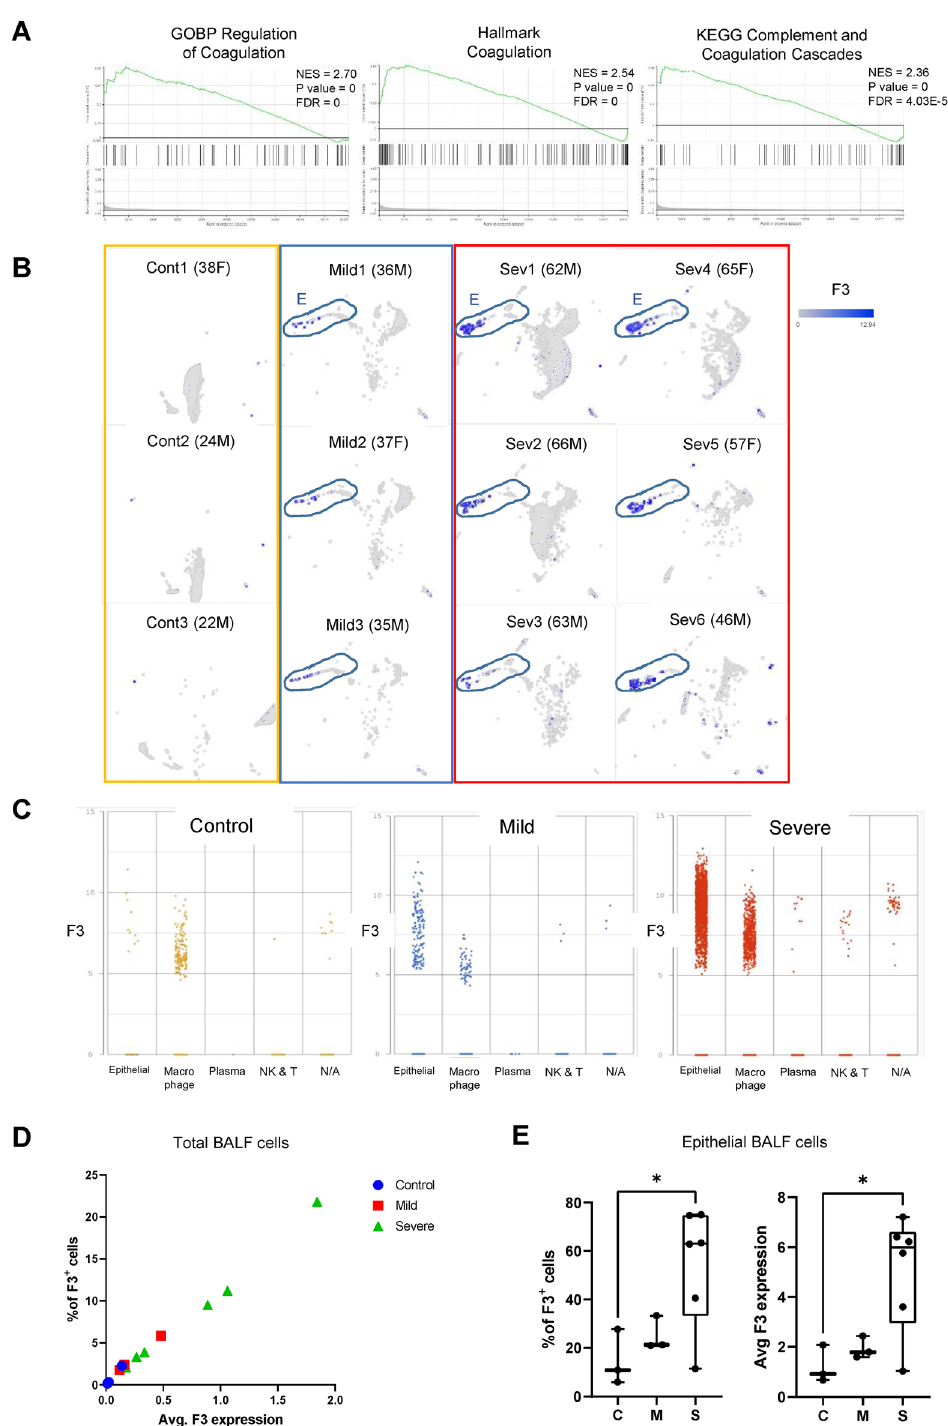
Figure 2. F3 is highly expressed in BALF epithelial cells derived from COVID-19 patients. ( A ) GSEA plots of GOBP coagulation pathways in BALF cells from COVID patients compared to those from healthy control 18 . ( B ) UMAP representation of F3 expression in control, mild, and severe COVID patients. Each gray dot represents a single cell. F3 expression levels are marked with blue color. Epithelial cells are outlined. ( C ) Dot plot of F3 levels across the major cell types within BALF cell populations. ( D ) Plot of the percentage of F3-positive (F3 + ) cells and average F3 expression level (arbitrary unit) in BALF cell populations. Each point represents one patient. ( E ) % of F3 + cells and average F3 expression in the BALF epithelial cell populations. Each point represents one patient. * p value <